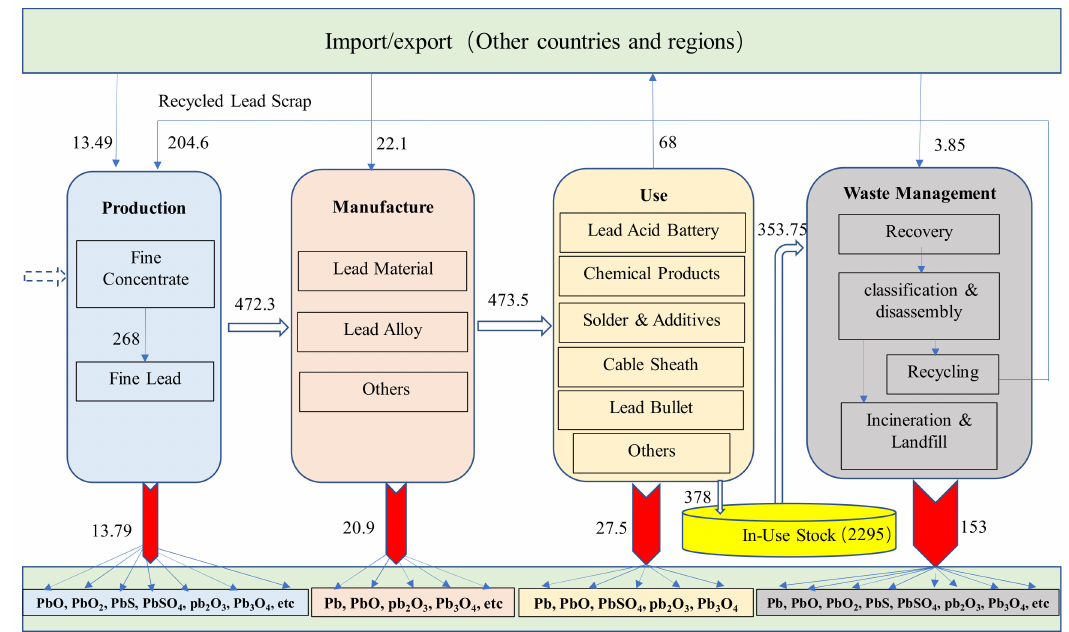
Figure 9. Material flow diagram of four phases of lead-bearing surface cycle in China in